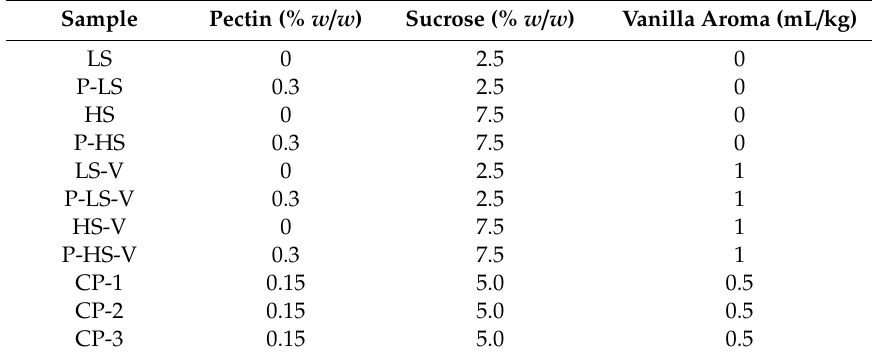
Table 1. Experimental screening design tested in both matrices, water and apple nectar, including pectin, sucrose and vanilla concentration.